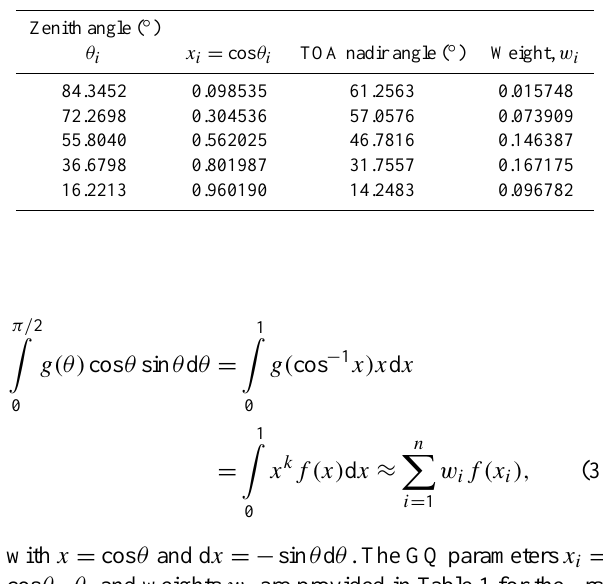
Table 1. Zenith angle, cosine of zenith angle, equivalent TOA nadir angle for IASI and corresponding weight for the five-node